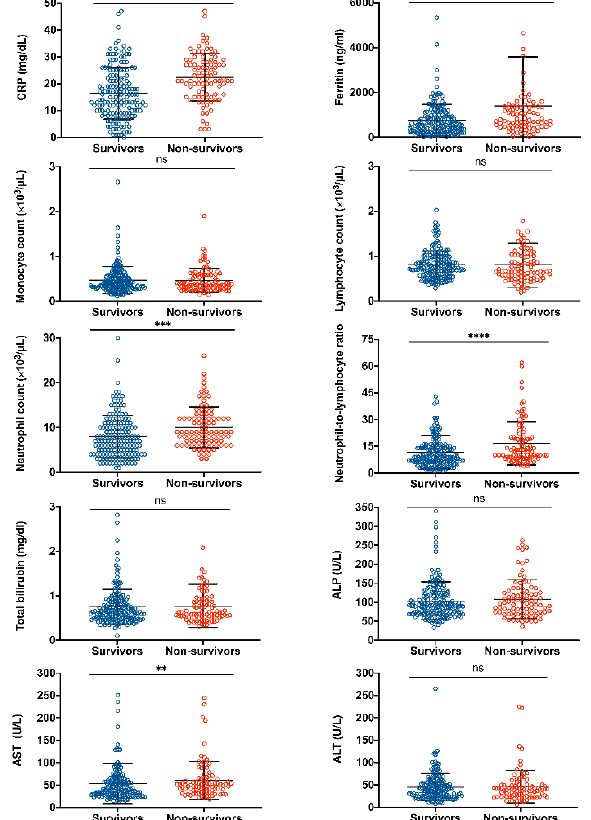
Figure 1. Laboratory parameters of COVID-19 patients evaluated upon hospital admission. C-reactive protein, CRP; alkaline phosphatase, ALP; aspartate aminotransferase, AST; alanine aminotransferase, ALT. Data are presented as median with IQR, two-tailed Mann–Whitney U test was performed. **** p < 0.0001, *** p < 0.001, ** p < 0.01, ns: no statistical